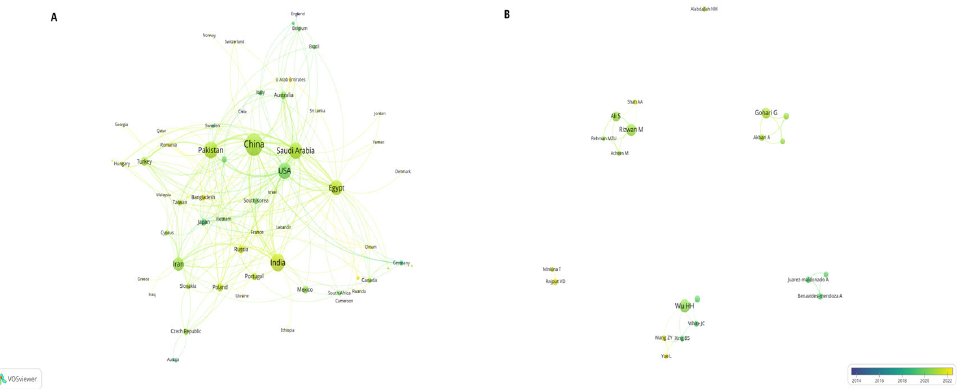
Figure 4. The collaboration network of countries/regions and authors. Note: The node’s size re ‐ veals how frequently it is used. The simultaneous relationship between the nodes is indicated by the link between the two nodes. The co ‐ occurrence frequency of the two sets of nodes is shown by the thickness of the connection between the two nodes. Different node colors signify various clus ‐ tering outcomes. The same as below.